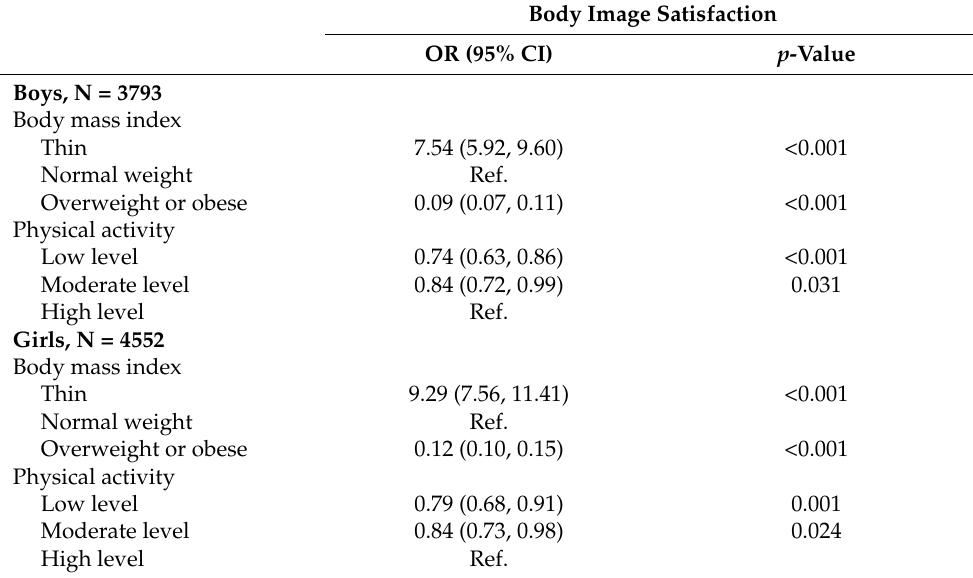
Table 3. Associations of body mass index and physical activity with body image